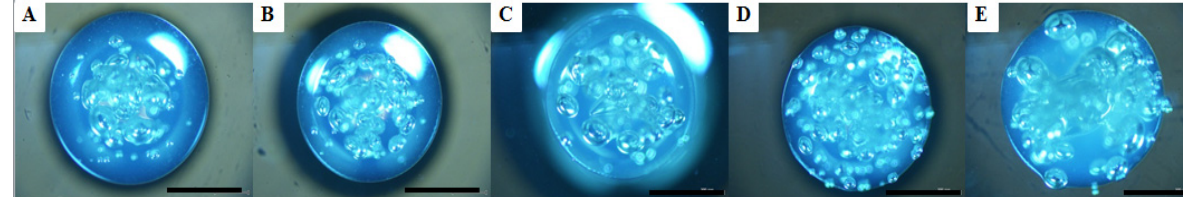
Figure 4. Photo images of a single alginate microparticle prepared by a fixed 36.5% H and different NaHCO concentrations: ( A ) 1%, ( B ) 2%, ( C ) 3%, ( D ) 4%, ( E ) 5%. All scale 3 bars are 1